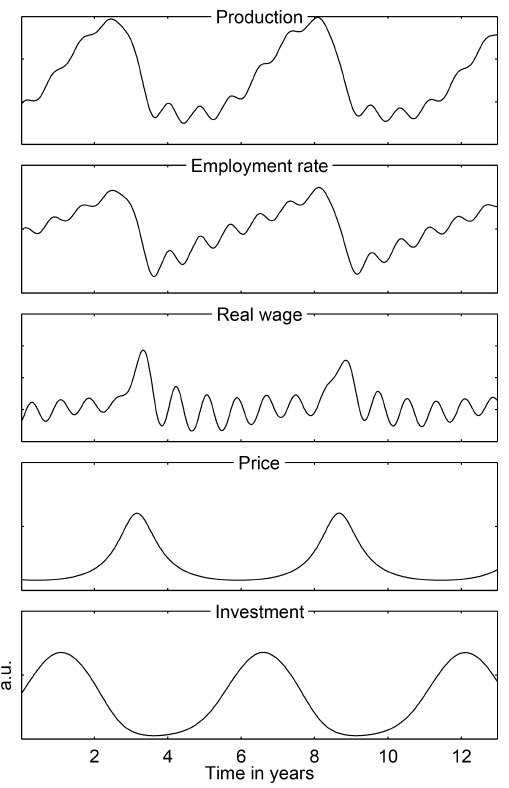
Figure 6. Endogenous limit cycle behavior of NEDyM for an in- vestment flexibility of α inv = 2 . 5; for all other parameter values, please see Hallegatte et al. (2008, Table 3). Reproduced from Groth et al. (2015a), with permission from AGU